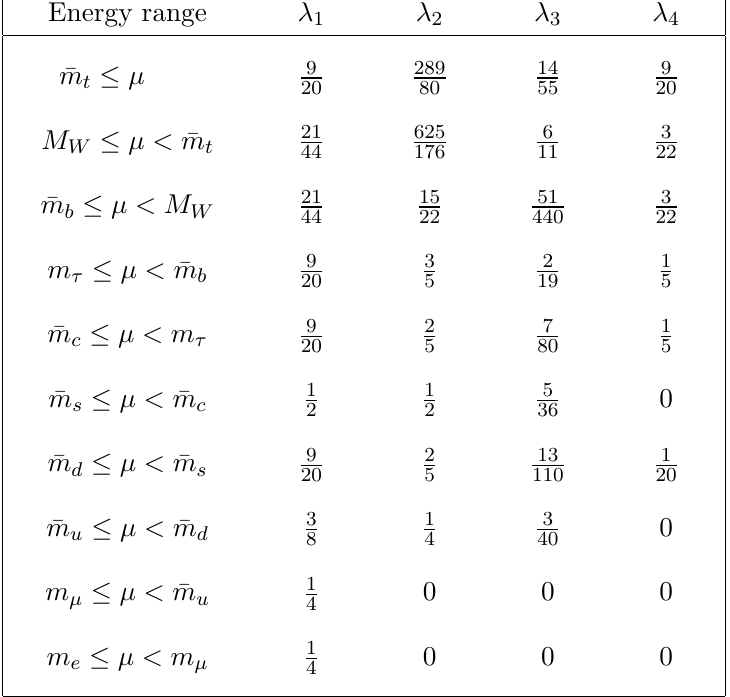
Table 2 . Coe(cid:14)cients entering the higher order RGE for the weak mixing